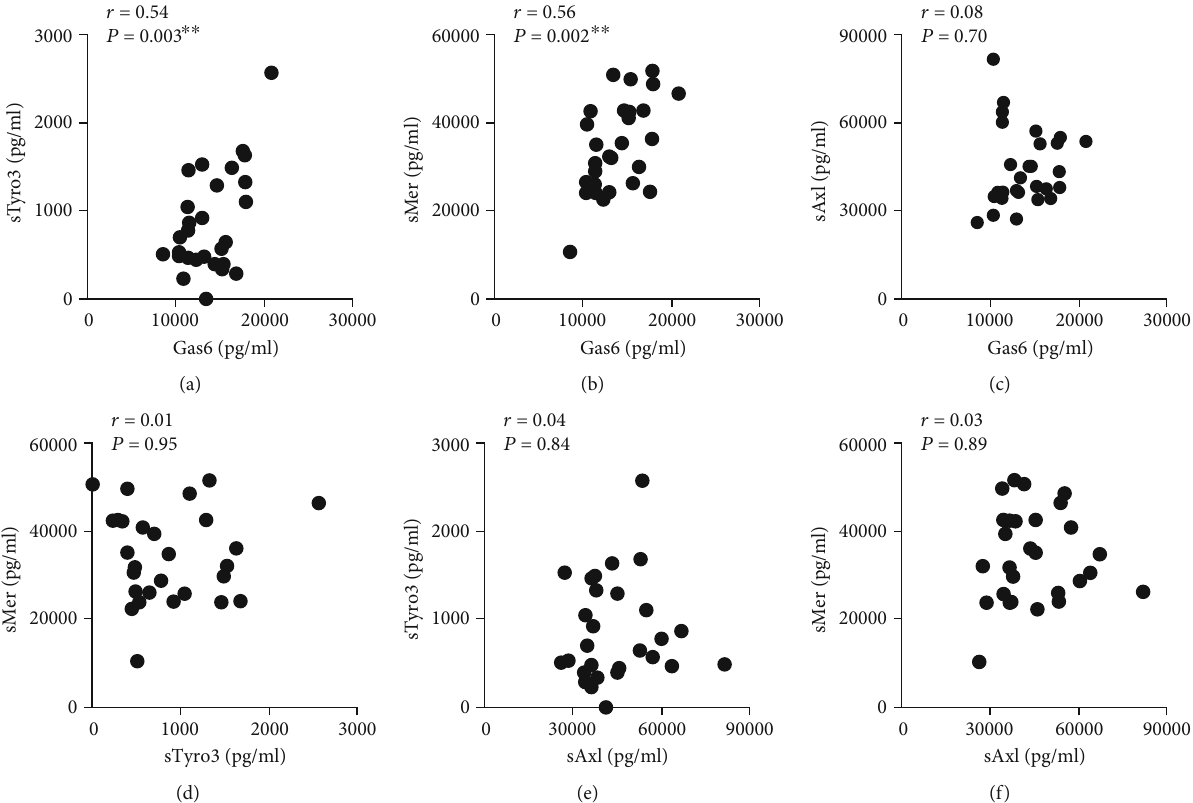
Figure 3: Relationship between soluble TAM receptor levels in the synovial fl uid of rheumatoid arthritis patients. Relationship between soluble Tyro3 (sTyro3), soluble Mer (sMer), soluble Axl (sAxl), and Gas6 levels in synovial fl uid of rheumatoid arthritis patients ( n = 28 ). Correlations are depicted for sTyro3 – Gas6 (a), sMer – Gas6 (b), sAxl – Gas6 (c), sMer – sTyro3 (d), sTyro3 – sAxl (e), and sMer – sAxl (f). Data are presented as the Pearson r value ( r ) and P value ( P ) for each correlation. ∗∗ P < 0 : 01